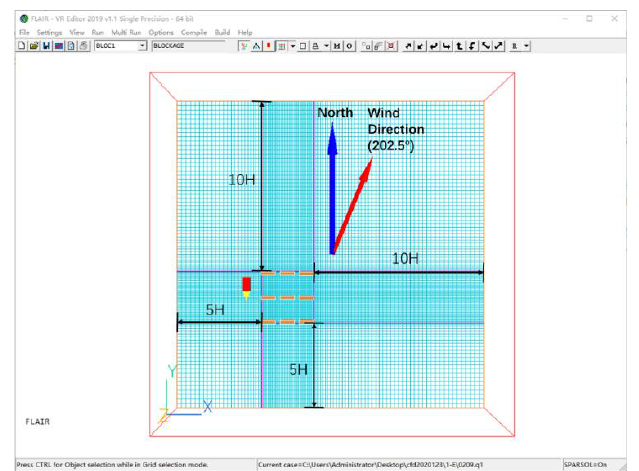
Figure A2. Phoenics grid mesh settings interface.